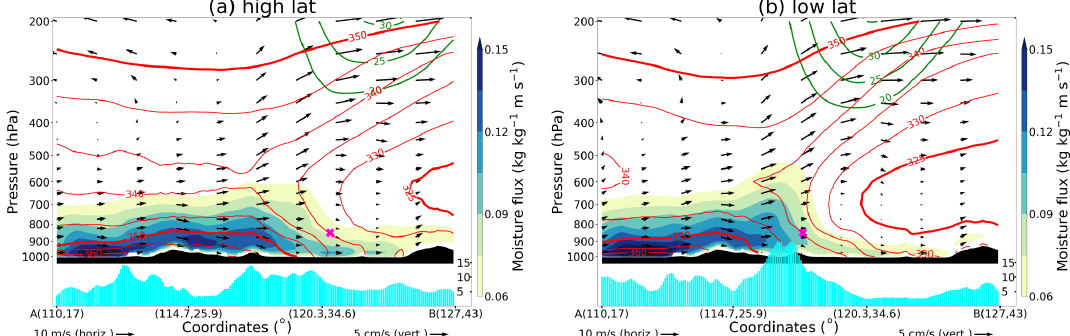
Figure 16. Cross-sections of dekadal mean moisture flux, equivalent potential temperature, wind speed, wind vectors, and precipitation at the Mei Yu stage (third dekad of June). As in Fig. 10c, but for (a) high-lat years and (b) low-lat years, without 2PVU lines and with bold 325 and 350K θ e contours to emphasise the shifting of the thermodynamic structure.